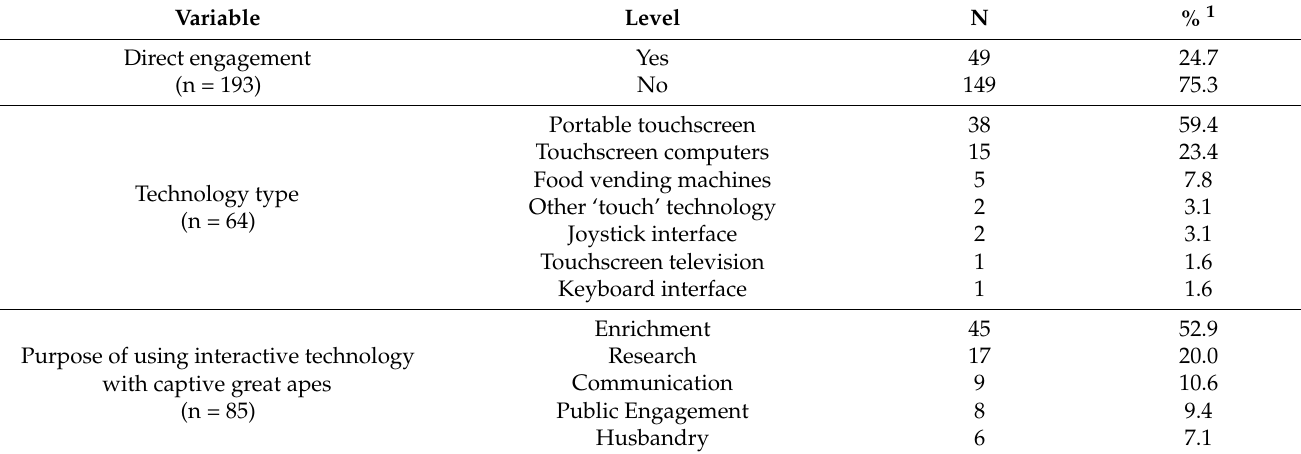
Table 3. Responses from a 43-question, online survey on the provision and use of interactive technology. Within the variable column, the total number of responses provided irrespective of the level is indicated (n), the proportion (%) of responses is provided, and N indicates the total number of responses for each question